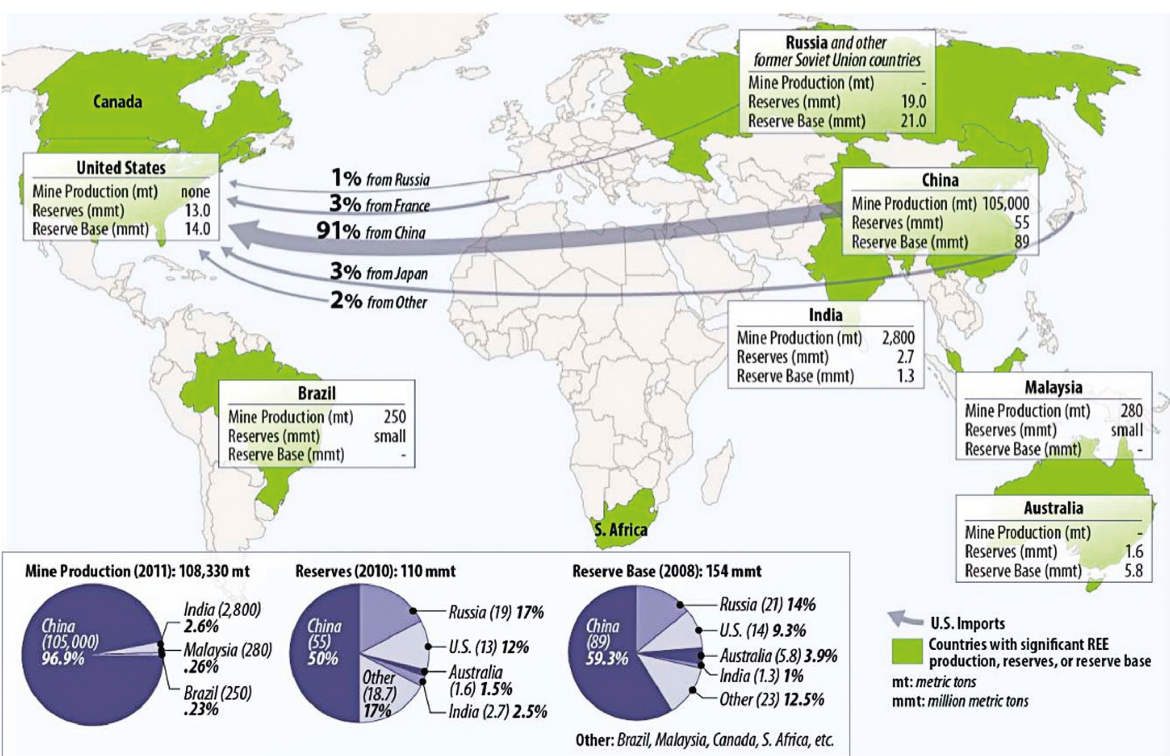
Figure 6: A representation of rare-earth world production, reserves, and US imports